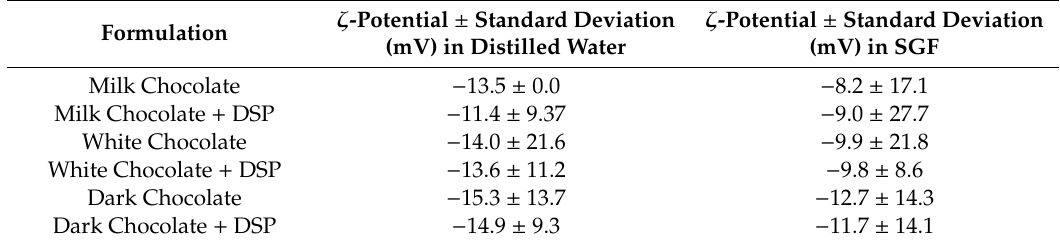
Table 4. ζ -potential values of chocolate Table 4. ζ-potential values of chocolate dispersions.